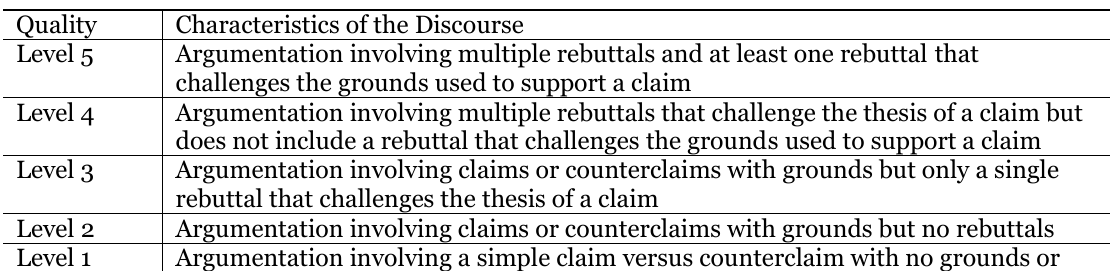
The Overall Quality of an Argumentation Within an Episode Determined Using a Hierarchy Based on Opposition (Clark & Sampson, 2008, p.